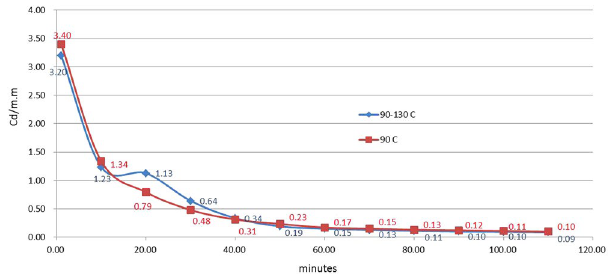
Figure 6. TL-time plot for tests performed with a temperature increase during afterglow. The square symbol curve is the afterglow curve for a film at a constant 90 °C throughout the lifetime. For the diamond symbol curve, the temperature was increased to 130 °C 10 minutes after excitation was terminated.